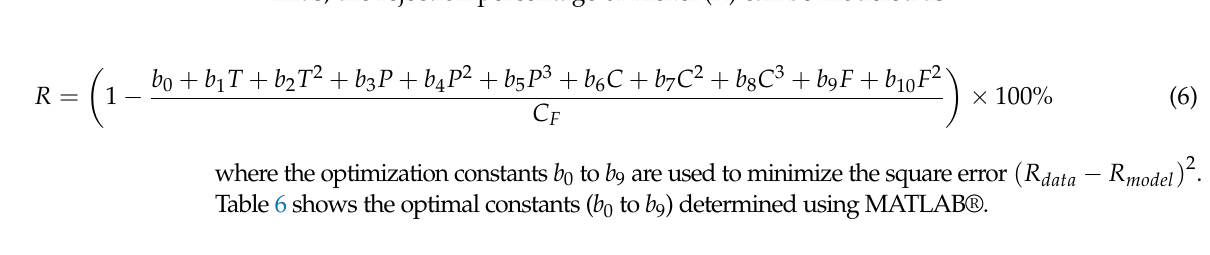
Table 5. Derived functions relating permeate concentration ( C p ) with other parameters. Permeate Flux vs. Figure 2b demonstrates nonlinear behavior with a similarity to parabolic curves. Figure 3b shows maxima and minima. The use of a quadratic equation would be insufficient for the model due to the singularity values of the minima/maxima; thus, it required a higher-order (cubic) function. Figure 4b, a plot of C p vs. concentration, yields a curve with more than one minimum; hence, a cubic fitting equation was adopted. Figure 5b demonstrates a nonlinear pattern with the flow, with one maximum value; hence, a quadratic model was used.